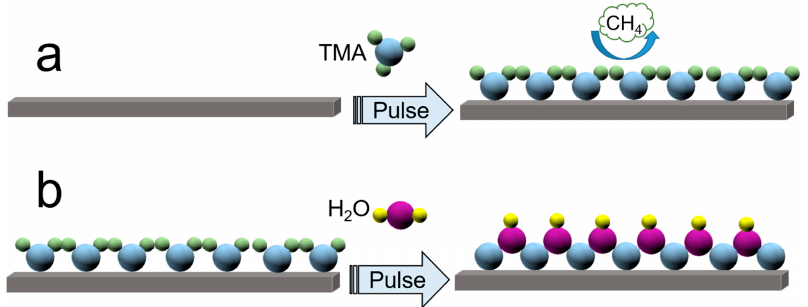
Figure 2. A model illustration for the atomic layer deposition (ALD) depositing Al 2 O 3 on hydroxyl groups functionalized substrate including step ( a ) and step ( b ) by using the trimethylaluminum (TMA) and water as reactants.